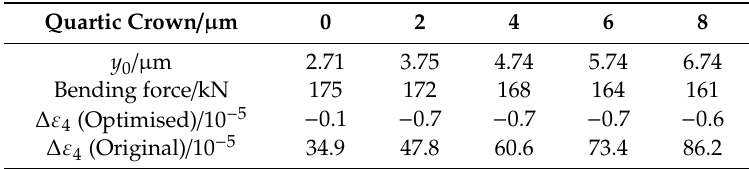
Table 3. Changes of the Δ ε 4 under different values of the quartic crown before and after the optimisation ( Δ T = 100 °C).